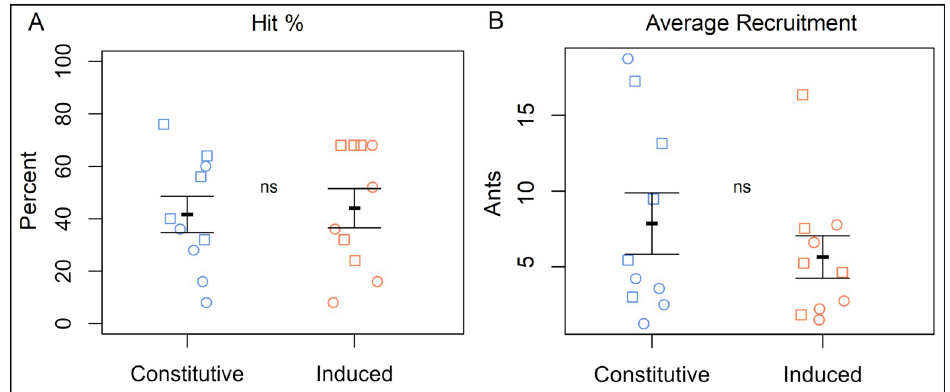
Fig 5. Ant recruitment in the field. (A) Proportion of tubes to which ants were successfully recruited in each transect (B) The mean number of ants per transect in tubes containing at least one ant. Squares are transects at site 1, circles are transects at site 2. Means ± 1 standard error shown with black brackets, ns = not significantly different at α = 0.05.